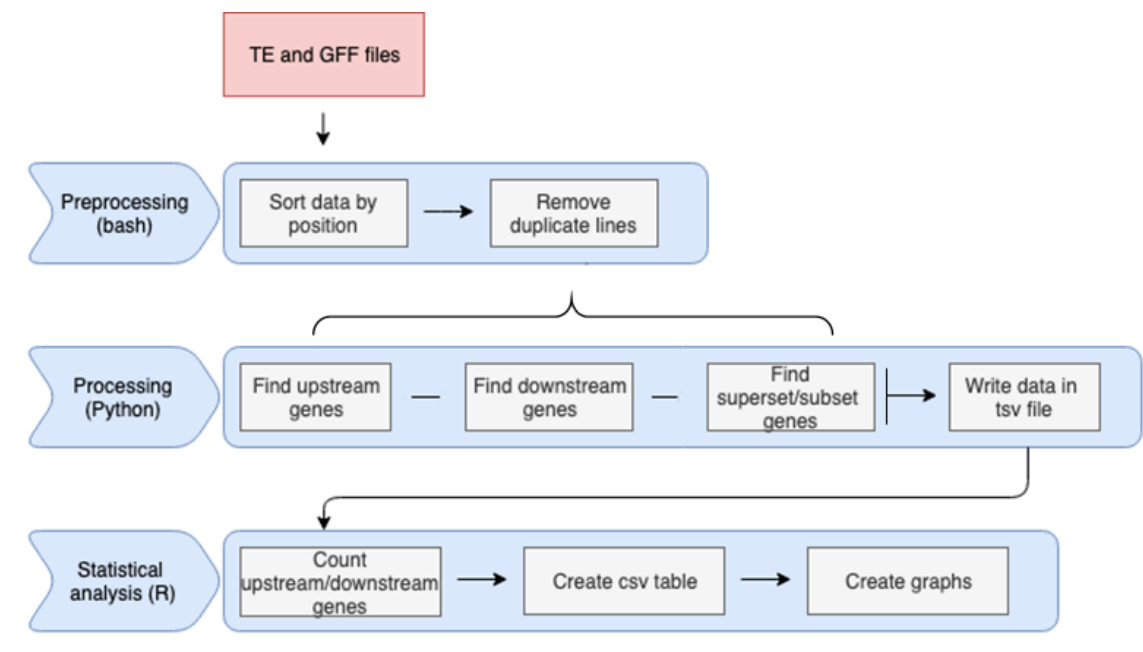
Figure 1. Scenarios of relationship between TEs and the closest genes in the host genome.